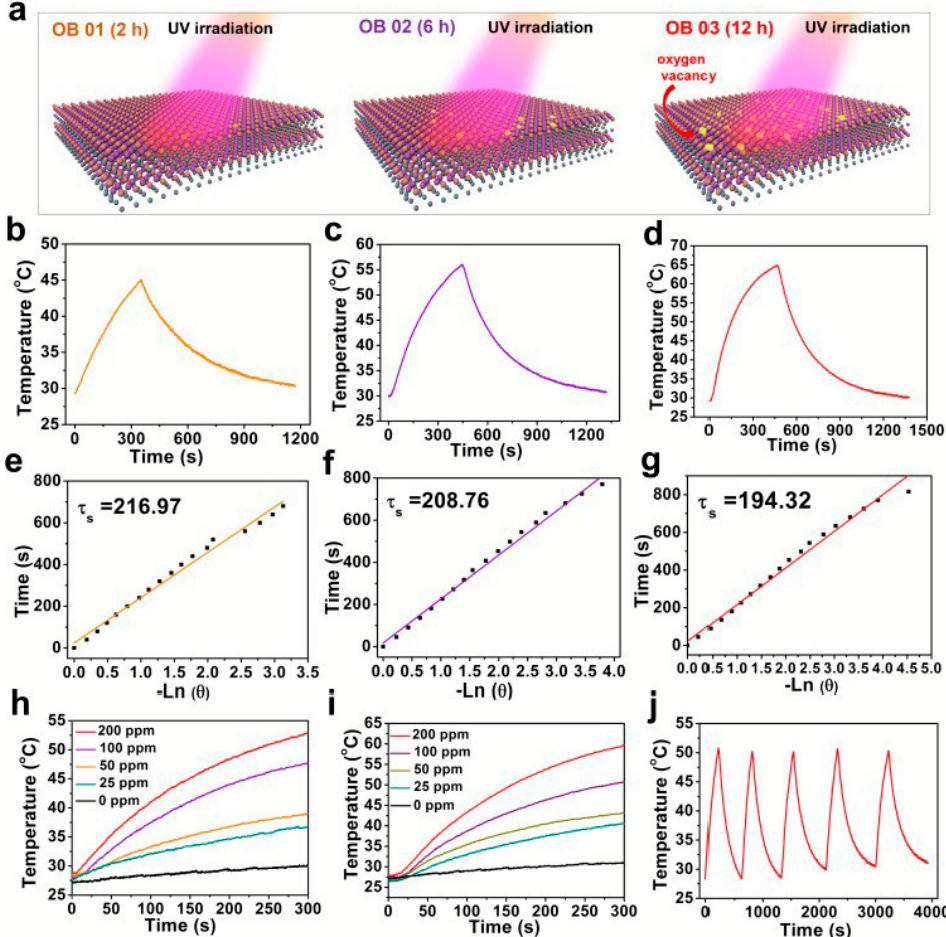
Figure 10. PTT performance of BiOCl induced by oxygen vacancies. Reproduced with permission from Ref. [65], 2020, Royal Society of Chemistry. ( a ) 3D schematic illustration of BiOCl nanosheets containing different amounts of oxygen vacancies after exposure to UV irradiation for 2, 6 and 12 h. ( b – g ) Photothermal effect ( b – d ) and time constant ( e – g ) of BiOCl nanosheets after the exposure to